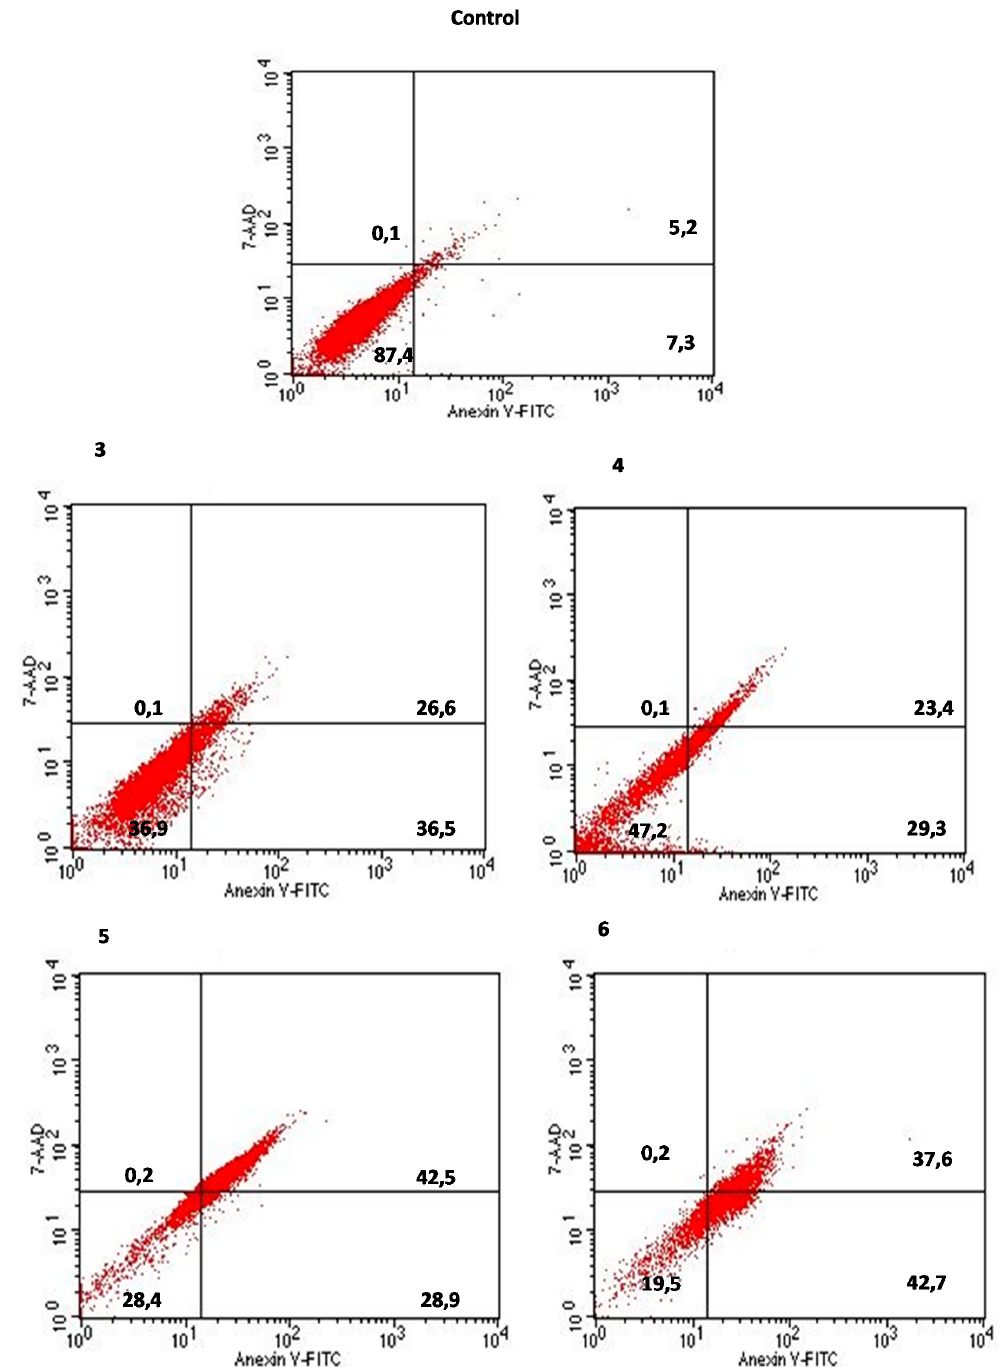
Figure 8. The e ff ect of compounds 3 – 6 on early and late apoptosis or necrosis in A549 cells, detected with Annexin V-FITC / 7-AAD by flow cytometry. The lower right quadrant shows early apoptotic cells (Annexin V-FITC positive and 7-AAD negative staining). The upper right and upper left quadrants represent the late stage of apoptotic or necrotic cells (Annexin V-FITC positive, 7-AAD positive, Annexin V-FITC negative and 7-AAD positive staining, respectively). The lower left quadrant represents unstained A549 cells (Annexin V-FITC negative, 7-AAD